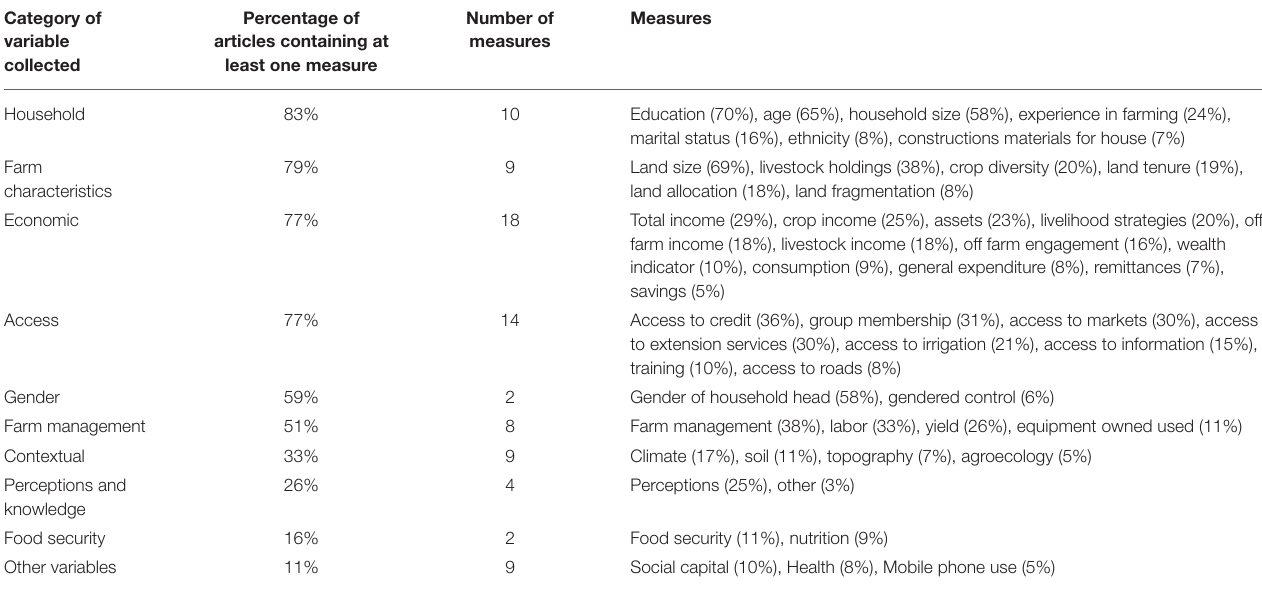
TABLE 4 | Summary of the themes covered by articles and the key variables that they examined. Category of variable